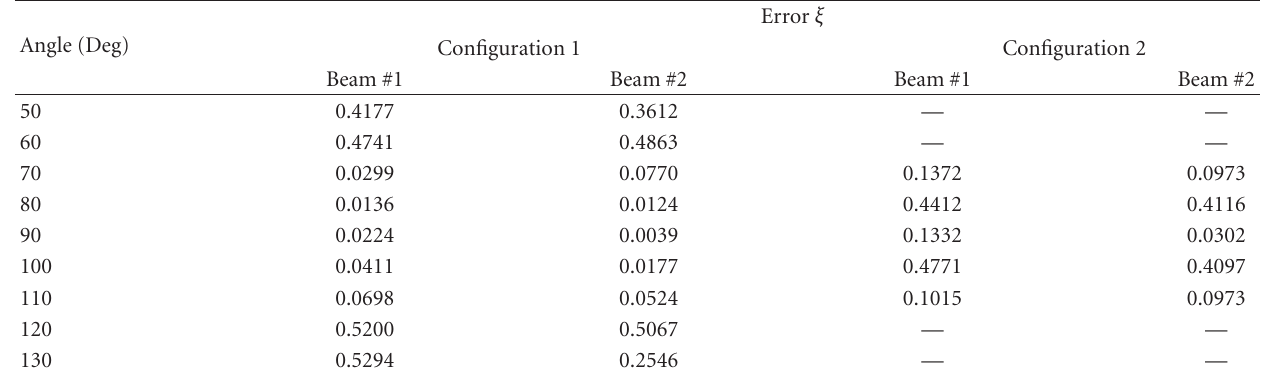
Table 1: Error ξ for the antenna steering in each evaluated scheme.